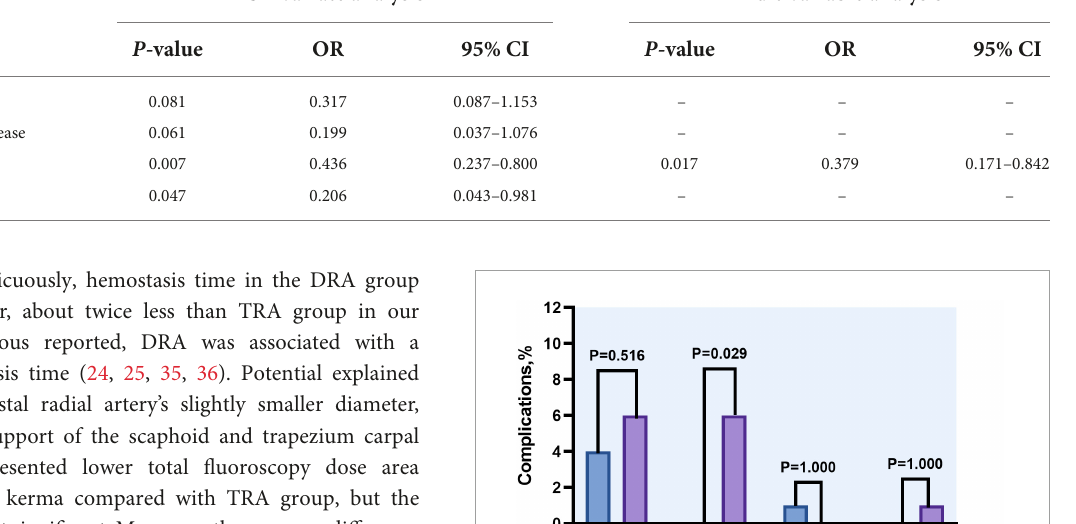
TABLE 4 Logistic regression analysis of forearm radial artery occlusion. Variable